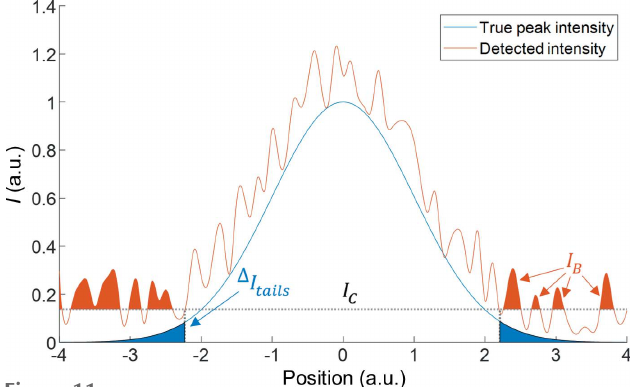
Figure 11 Schematic overview of the origins of the seed-skewness corrections ‘hidden tails’ and ‘included noise’. The most intense parts of the background, I B , and the weakest parts of the peak tail, (cid:2) I tails , will be incorrectly assigned to the peak and the background,